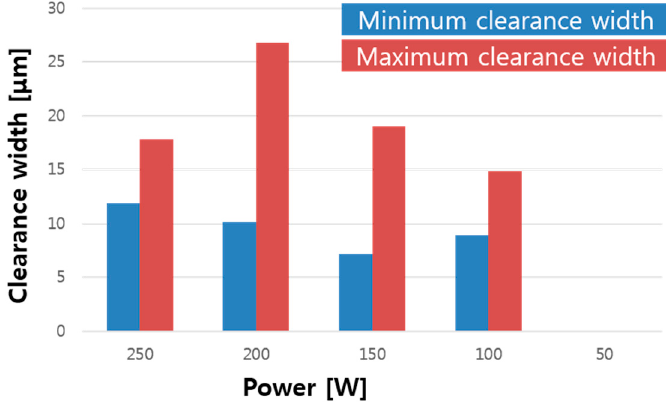
Figure 13. SEM image with a laser power of 100 W. Figure 7. Clearance width by laser power. Figure 7. Clearance width by laser power.